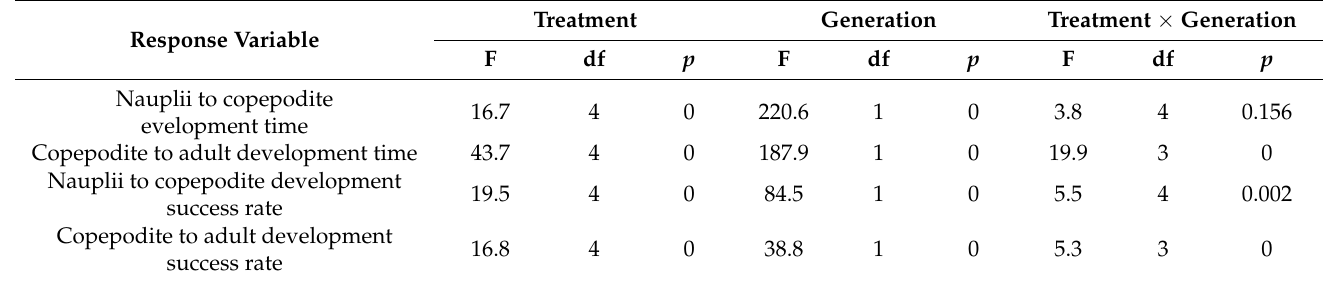
Table 6. Effects of K. mikimotoi concentration and generation on the development in T. japonicus